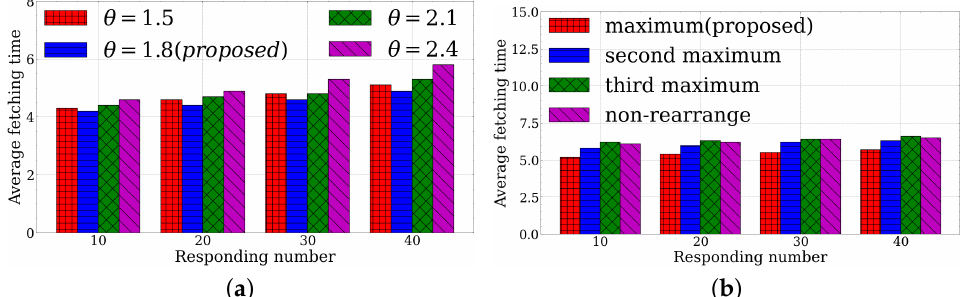
Figure 3. KCDF evaluation under different link-initialized coefficients and rearrange conditions. ( a ) Link-initialized coefficient. ( b ) Rearrange